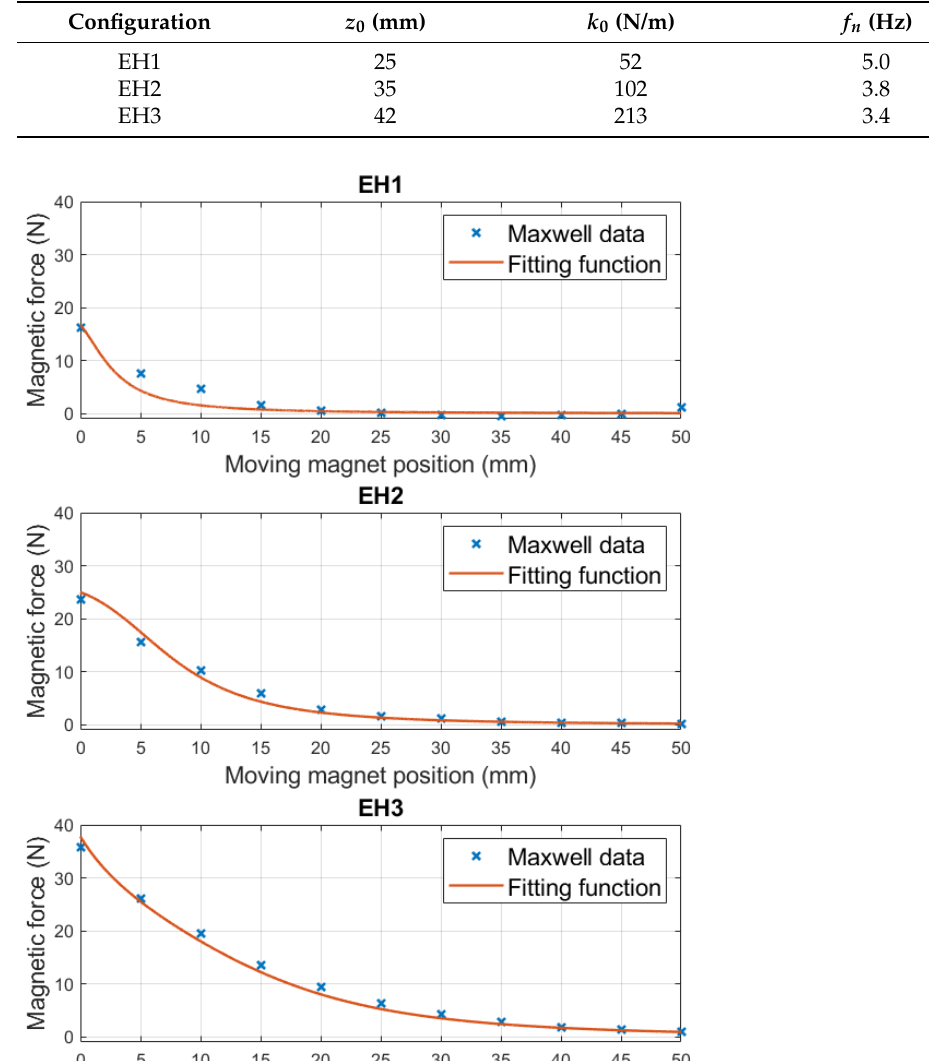
Table 4. Static simulations results.